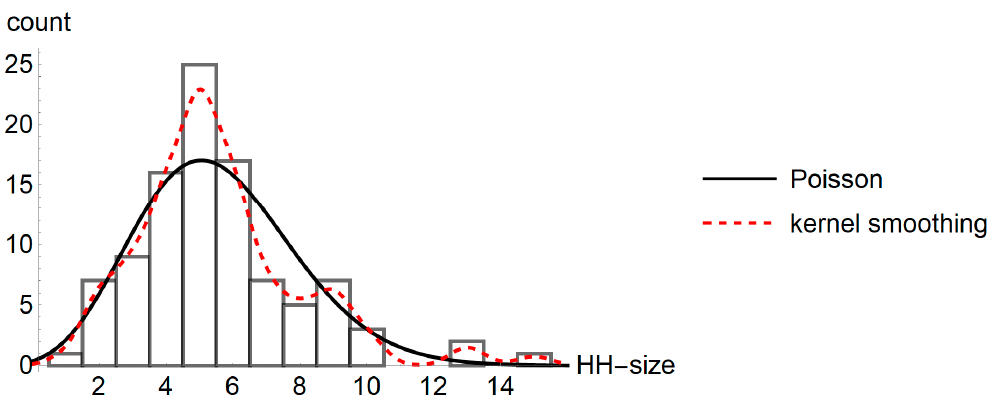
Figure 3. Histogram of HH-sizes of the slum (100 data) and related probability density functions: The black curve is the Poisson distribution (Section 6) fitted to the data (the good fit was confirmed by a distribution fit test based on Pearson’s chi-squared statistic: p -value 26% using simulations) and the dashed red curve is the smooth-kernel distribution (Section 6) of the data (plotted to visualize the good fit). To obtain comparable scales these were multiplied with 100 (100 data times 1 bin width); plot and computations using Mathematica 11.3.